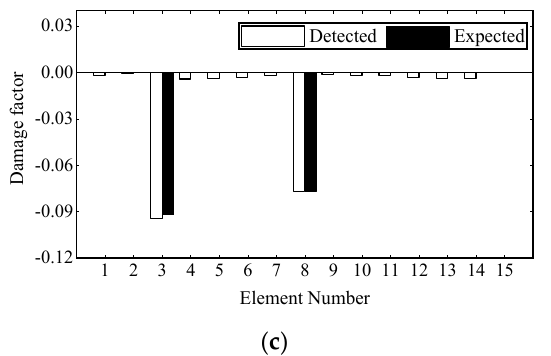
Figure 4. Damage identification results under transient excitation: ( a ) scenario 1; ( b ) scenario 2; ( c ) scenario 3.